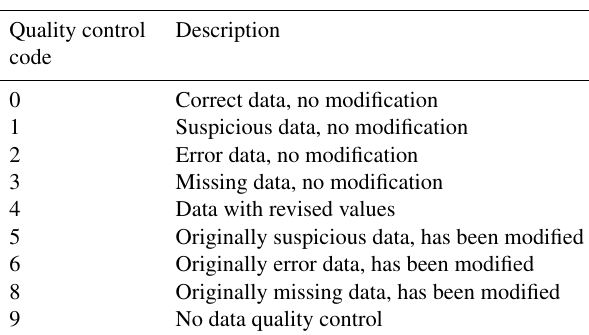
Table 3. Quality control codes for the meteorological station data. The variable names are suffixed with